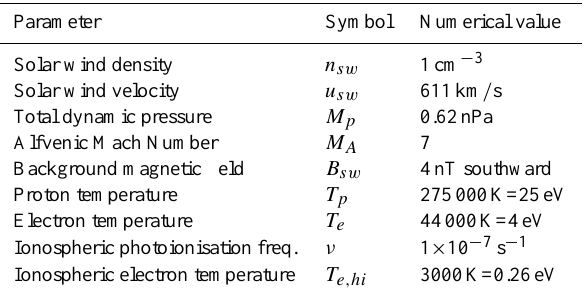
Table 2. Input parameters for the simulation run 2.